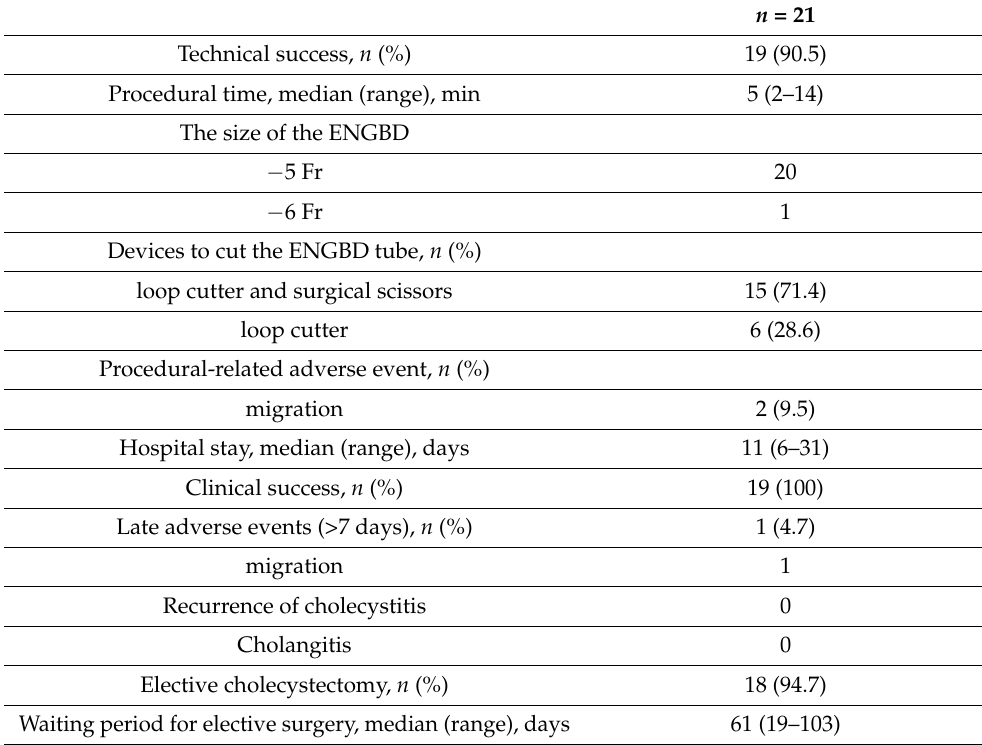
Table 2. Clinical outcomes of the endoscopic internalization by cutting